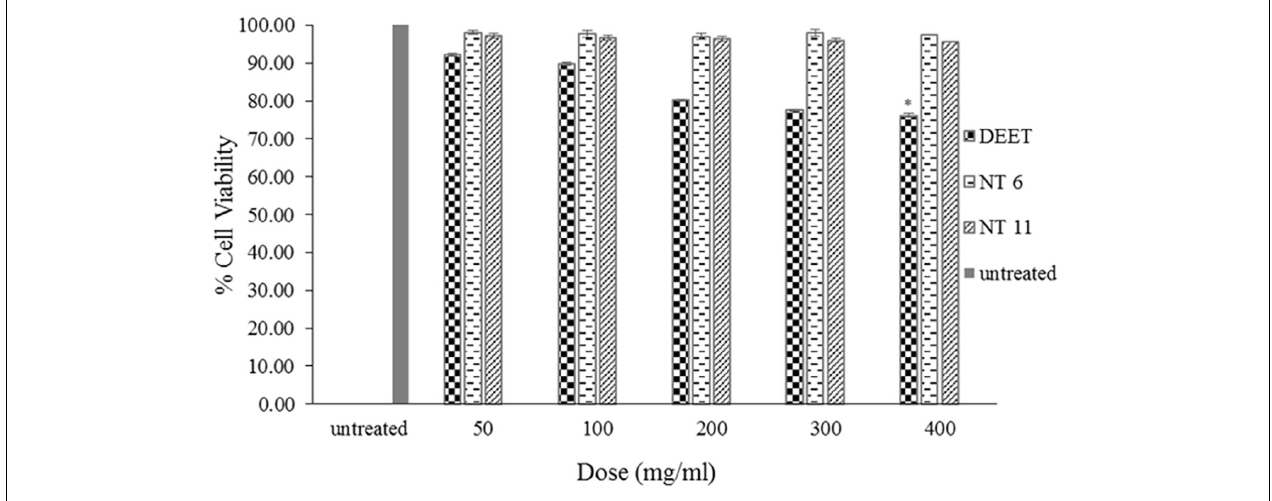
FIGURE 8 | Percentage cell viability of L929 cells after 48 h exposure to NT 6, NT 11, and DEET at different doses of treatment using the MTS assay (mean ± SD, n = 3, ∗ p < 0.05 (LSD